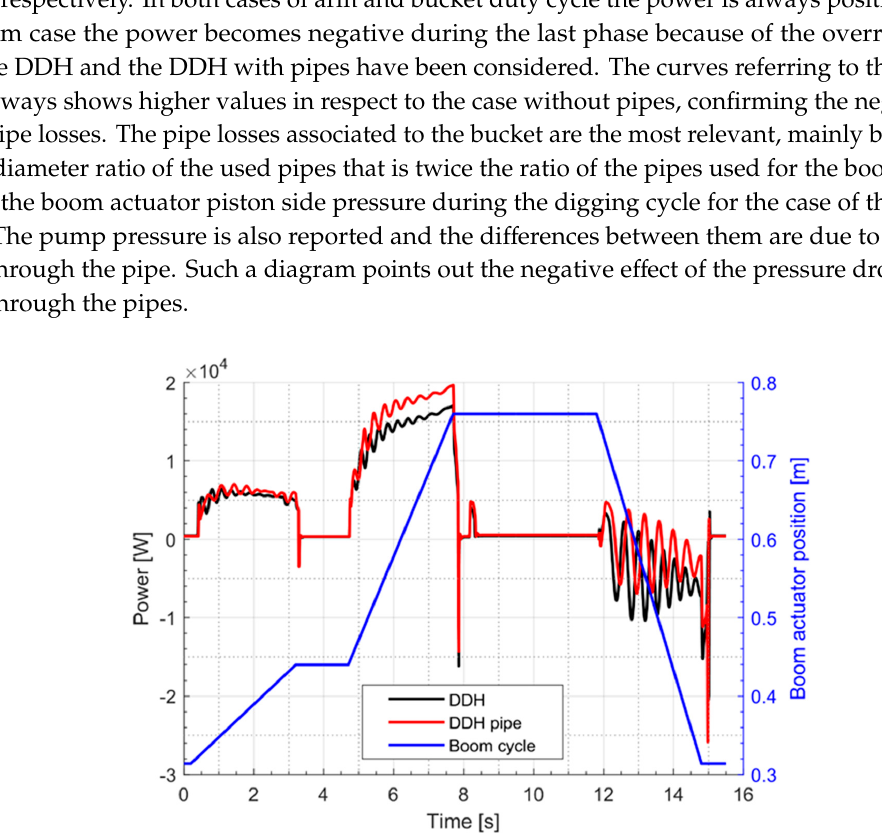
Figure 10. Electric motor power boom actuator— direct driven hydraulics (DDH) and DDH with pipes.